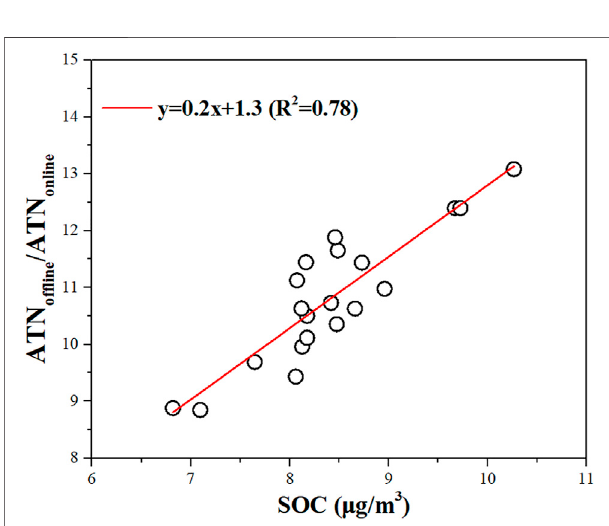
FIGURE 2 | The relationship between secondary organic carbon (SOC) and the ratio of light attenuation (ATN) by of fl ine sampling to that by online sampling without a denuder (ATN of fl ine /ATN online